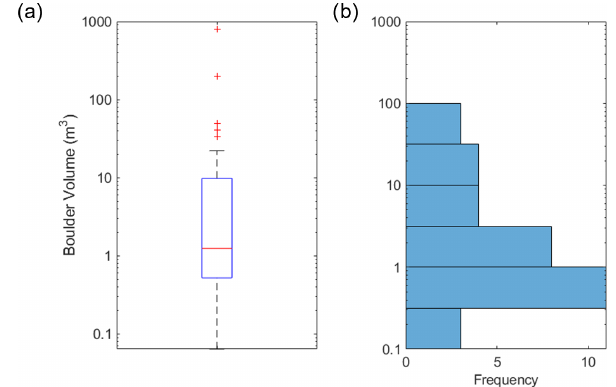
Figure 6. (a) Boxplot of the measured boulder volumes ( n = 36) in the field, indicating a median boulder volume of 1m 3 . (b) His- togram of the measured boulder volumes in the